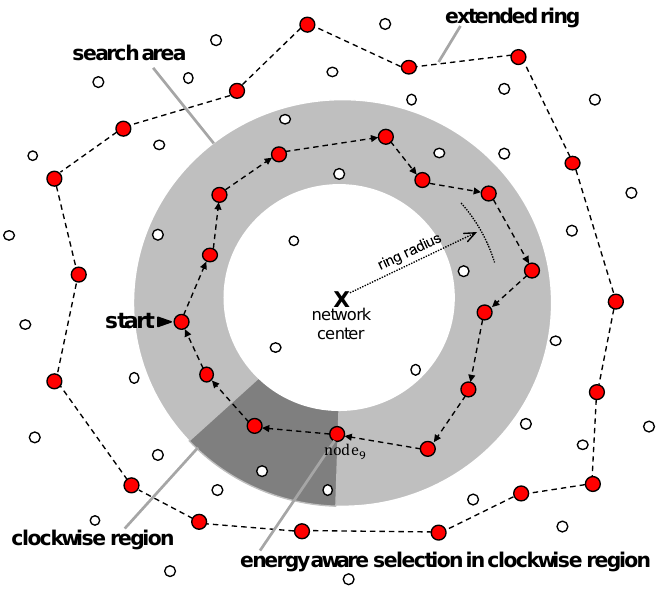
Figure 4. Ring construction of MRR